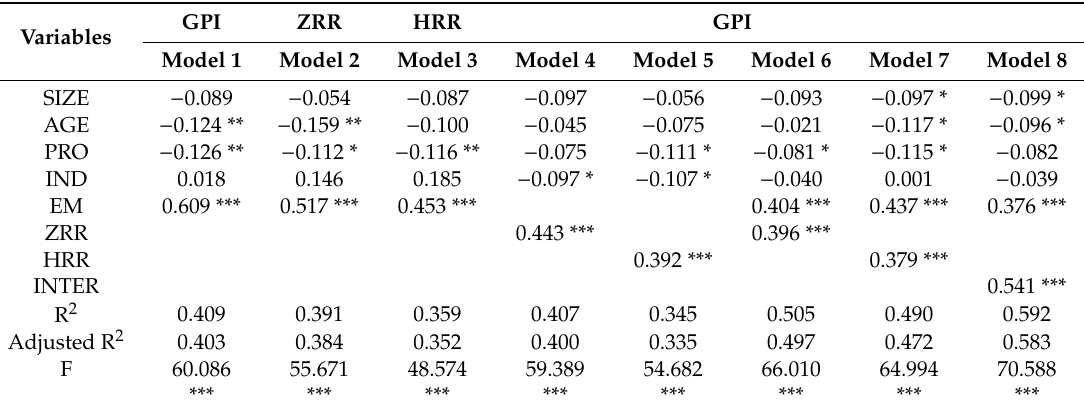
Table 2. Results of regression